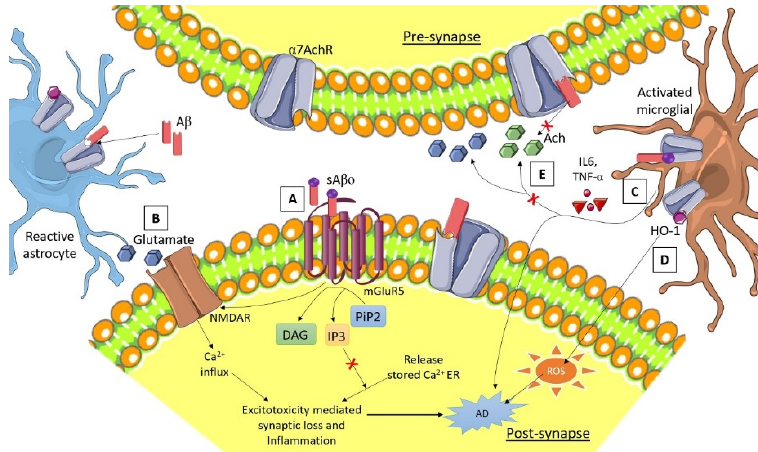
Figure 2. Astrocyte and neuron interaction and regulation of calcium